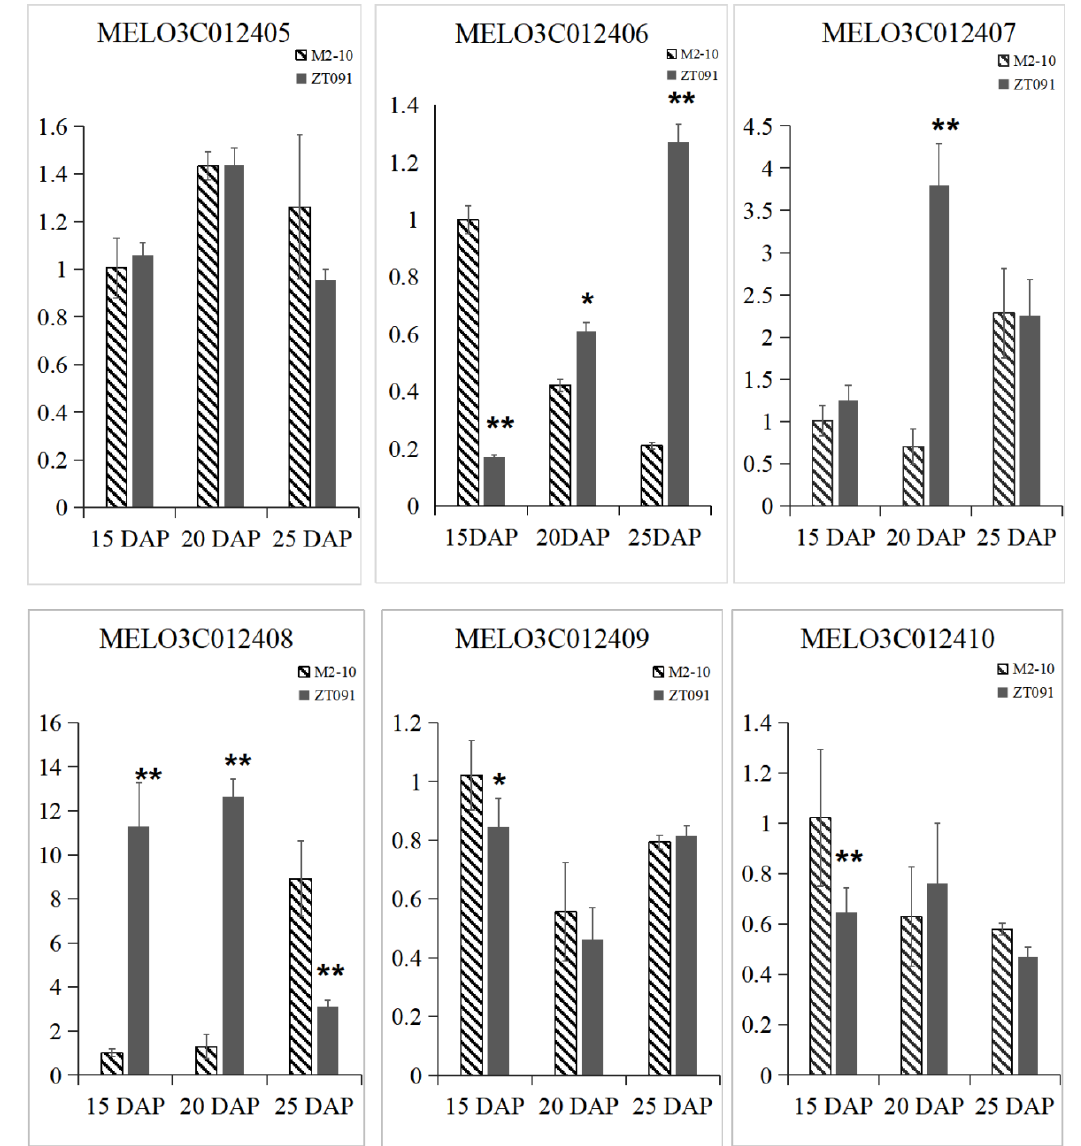
Figure 3. Relative expression levels of six candidate genes in None MFA melon ‘M2-10’ and MFA melon ‘ZT00091’. Six genes were quantified using the 2 −ΔΔCT method. For the two parents, the expression level of the respective genes was determined at 15, 20, and 25 days after pollination, respectively. Each was repeated three times, and 5 plants were mixed in equal amounts to form one replicate in two parents. The striped bar represents M2-10, and the dark gray bar represents ZT00091. ** indicates an extremely significant difference, p < 0.01; * indicates a significant difference, p < 0.05.